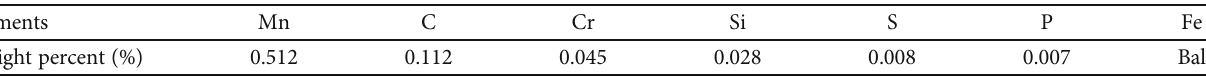
Table 1: The St-37 substrate chemical composition.